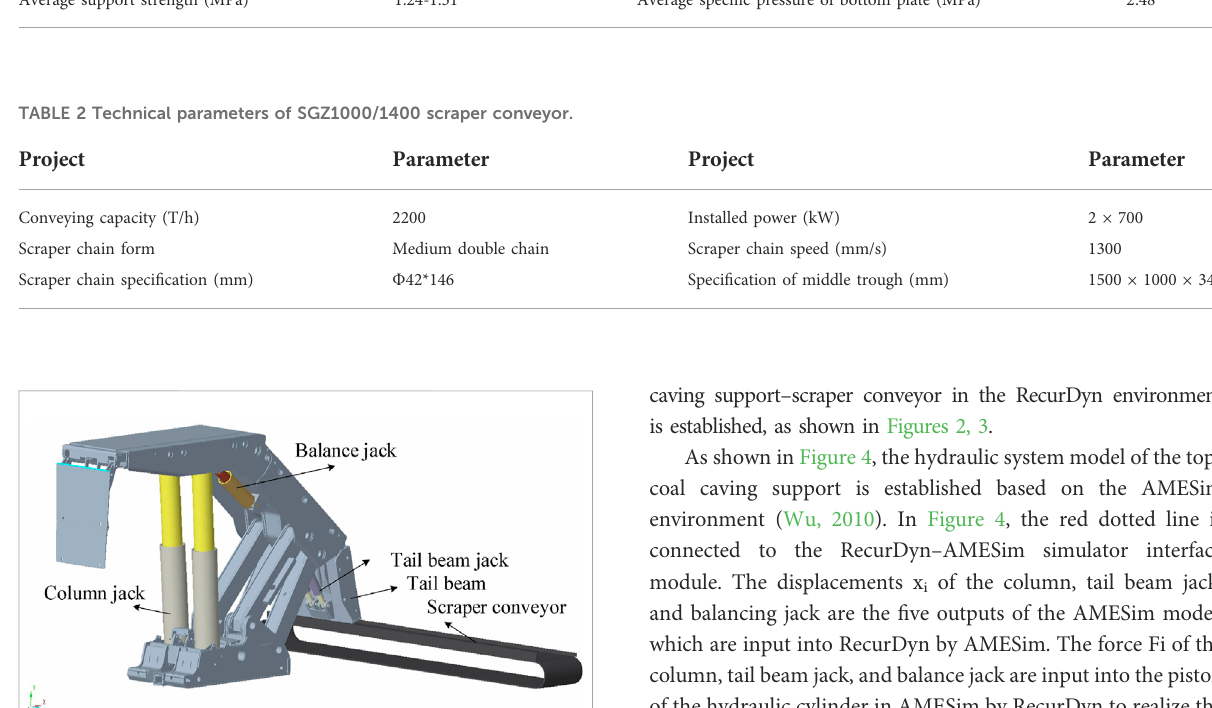
FIGURE 2 Three-dimensional solid